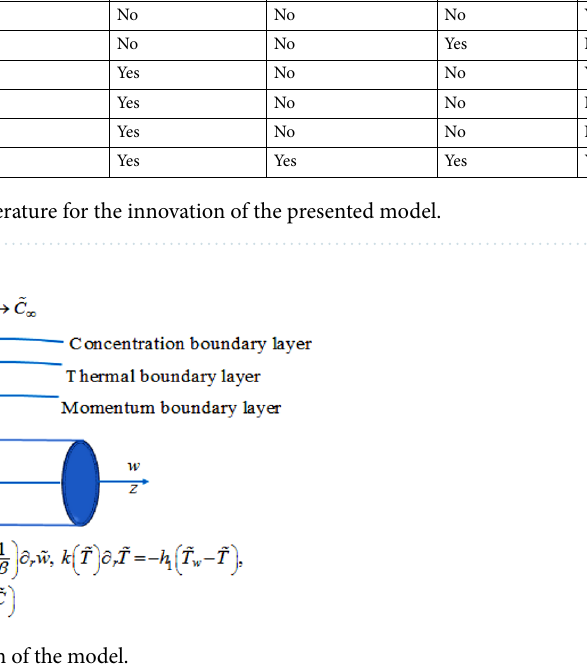
Figure 1. Flow representation of the